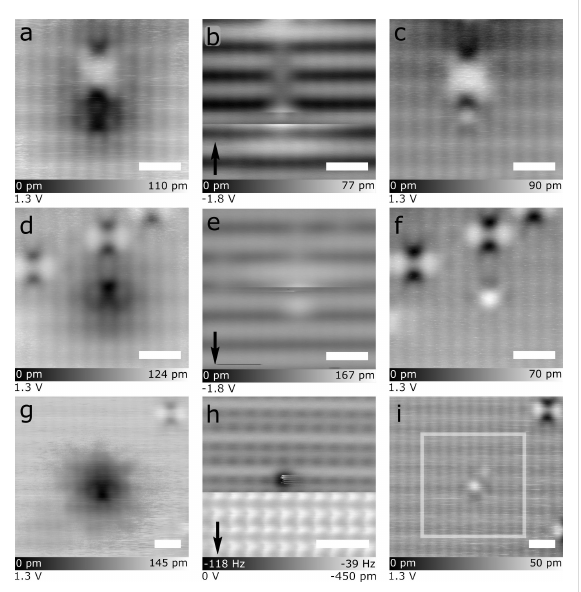
Figure 5: Tip-induced removal of hydrogen atoms decorating neutral point defects. (a–c), (d–f), and (g–i) show three instances of the apparent neutralization of a negatively charged defect. (a,d,g) Empty states images of the negatively charged H-decorated point defect before H liberation. (b,e) Show filled states STM removal events, while (h) shows an AFM removal event. The arrows in the lower left indicate the scan direction, with contrast changes in the scan indicating a removal event has occurred. (c,f,i) Empty states STM images of the same frames as (a,d,g), but after the H removal. The point defects no longer display charge-induced band bending around their location. The white box in (i) indicates the size of the scan frame in (h). Scale bars are 1